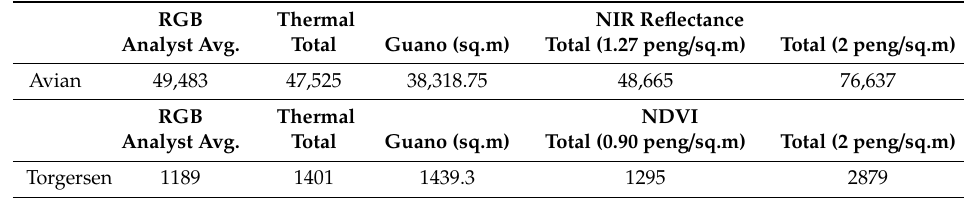
Table 3. Summary of penguin counts and the guano area. The bolded column headings indicate the imagery the counts were derived from. This table shows the average of the analyst counts on each island (RGB), the total count of penguins from the workflow (thermal), the total guano area calculated from the workflow (multispectral), and the subsequent population estimations calculated using the guano area. We estimated the populations using the guano area in two ways. First, by using the average of the workflow and analyst counts and the area of guano from the workflow, and second, using the common ratio of 2 penguins per square meter of